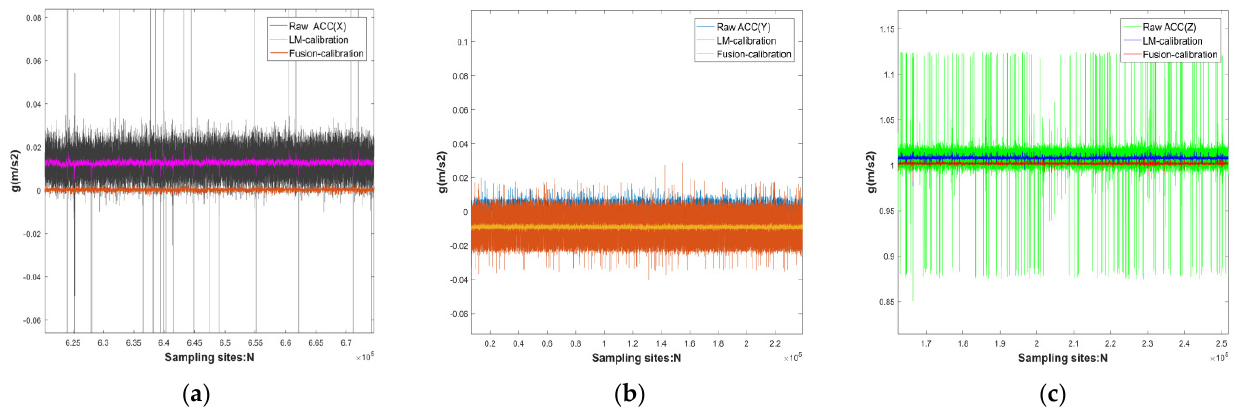
Figure 7. Comparison of original sensor, calibrated single MEMS, and fused calibrated MEMS in the MEMS0 accelerometer at standstill: ( a ) X -axis of the accelerometer; ( b ) Y -axis of the accelerometer; ( c ) Z -axis of the accelerometer.